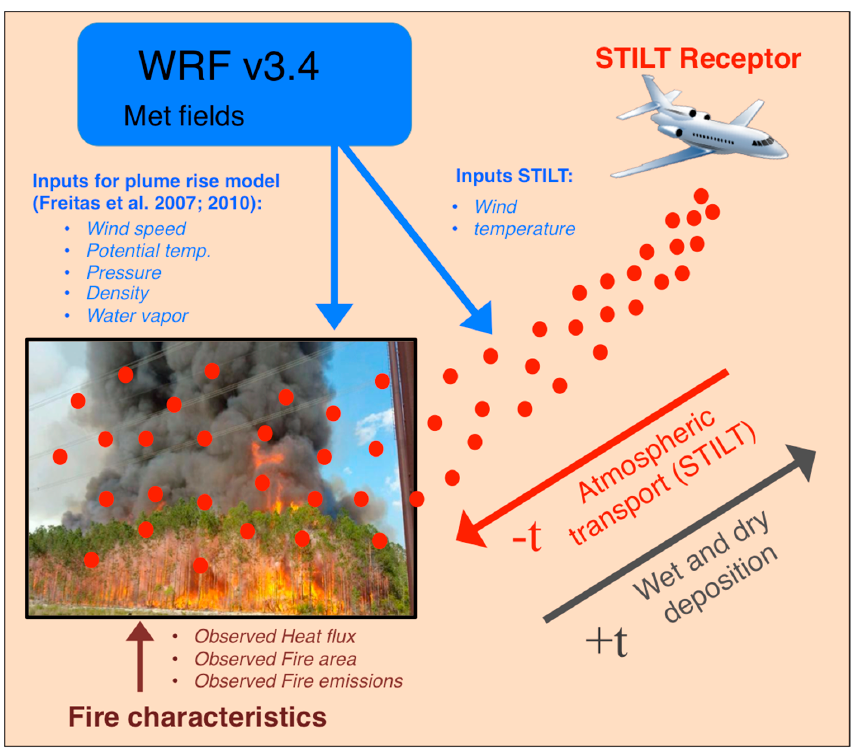
Figure 6. Schematic of the WRF–STILT (Stochastic Time-Inverted Lagrangian Transport) modeling framework used to model downwind smoke transport.